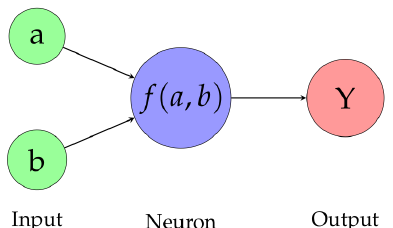
Figure 4. Basic structure of neuron in GMDH-based neural